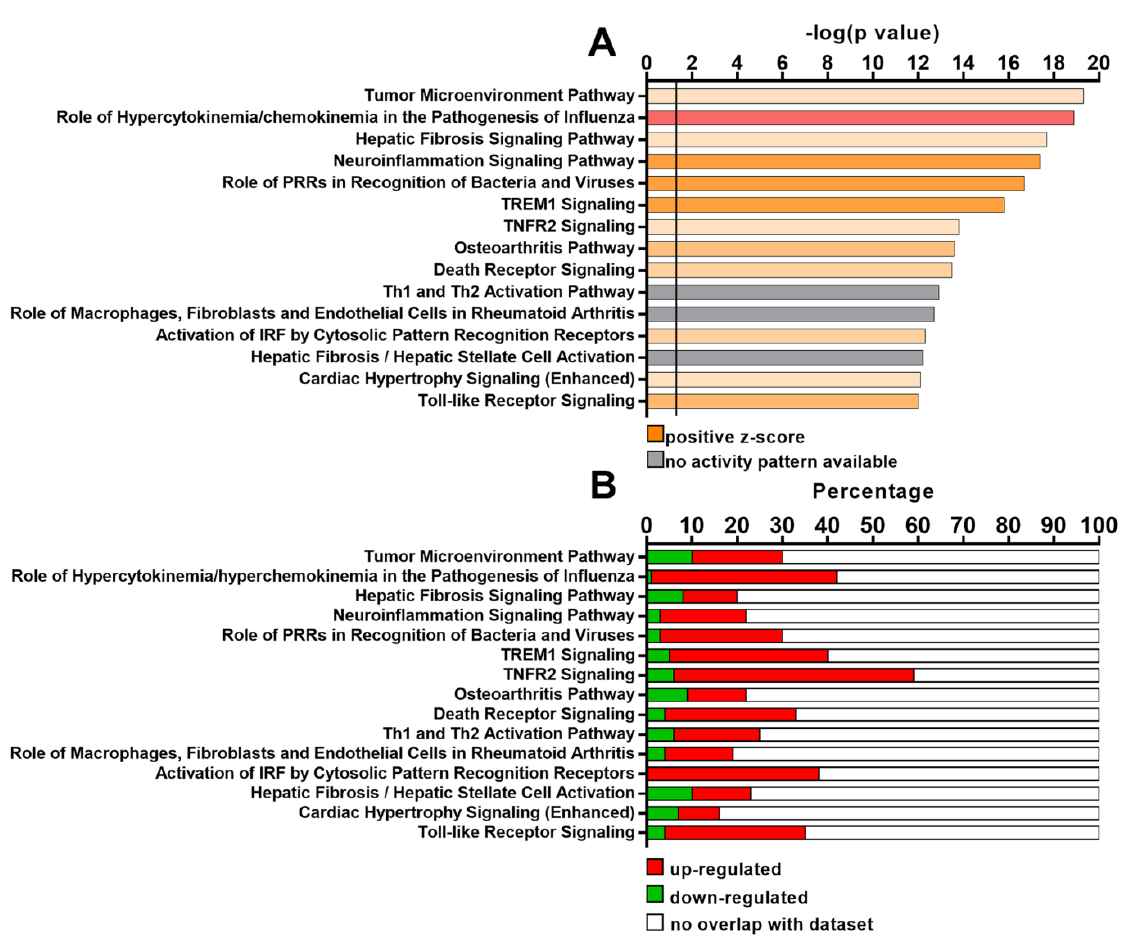
Figure 3 . Functional analysis of BMDMs exposed to NSCLC cell line CMs by IPA. ( A ) Top 15 differentially regulated canonical pathways between Group 1 and Group 2 BMDMs resulted from IPA “Core Analysis” performed on annotated transcripts with FDR < 0.01 and − 2 ≤ FC ≥ 2. The identified pathways are represented on the y -axis. On the x -axis, -log( p -value) as determined by Fisher’s exact test, is shown. The black straight line indicates the minimum significance level. ( B ) Stacked bar chart showing the percentage of up-regulated (red), down-regulated (green) and not overlapping (white) genes retrieved from our microarray analysis in each canonical pathway.